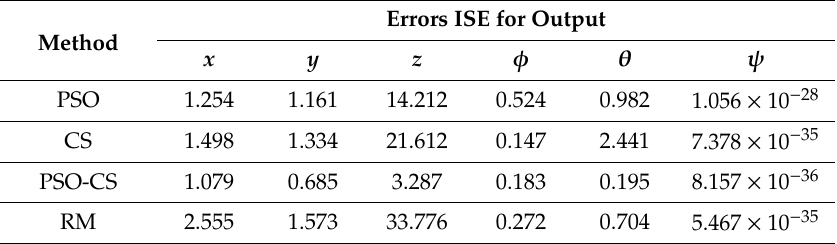
Table 6. Errors (ISE-Integral Square Error) obtained Particle Swarm Optimization (PSO), Cuckoo Search (CS), Particle Swarm Optimization-Cuckoo Search (PSO-CS), and Reference Model (RM) for the quadrotor with disturbance (rectangular trajectory).